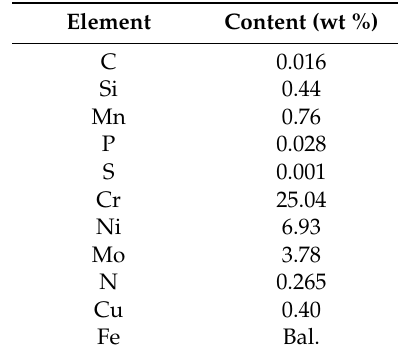
Table 1. Chemical composition (wt %) of 2507 SDSS, measured with X-ray fluorescence and combustion analysis. Element Content (wt %) C 0.016